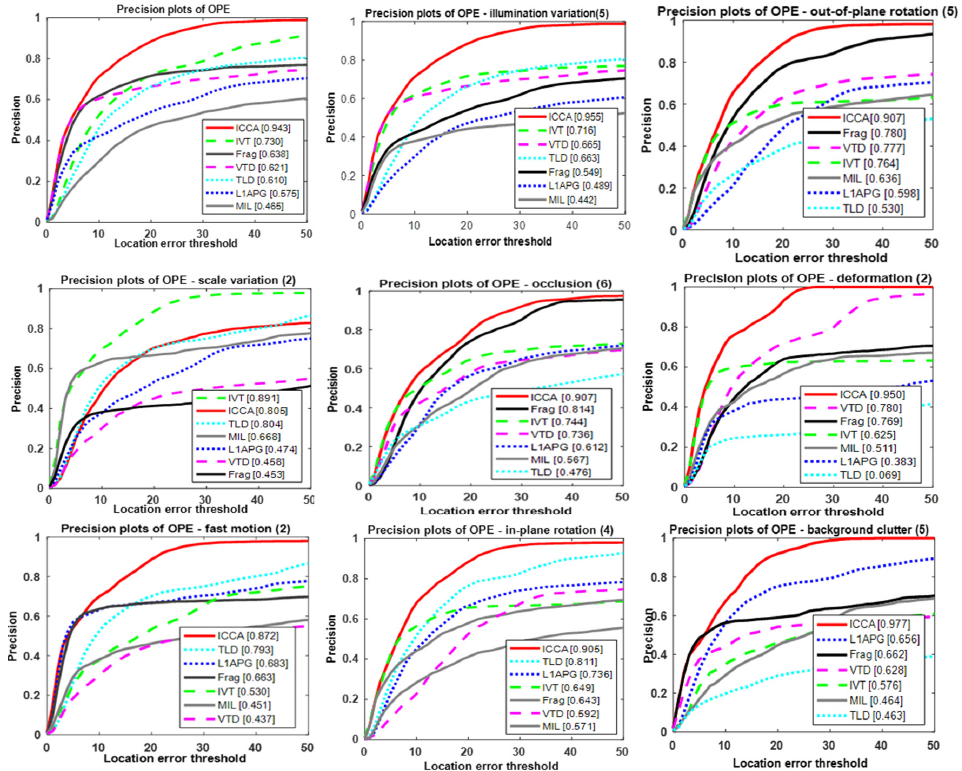
Figure 4. Precision rate of seven trackers on different attributes.